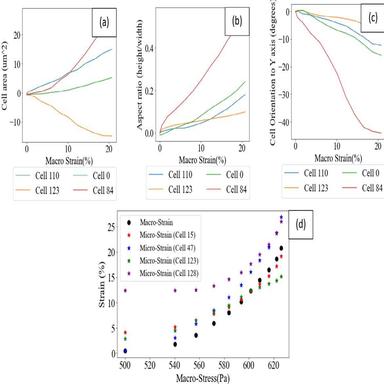
Material analysis step to extract geometrical and material characteristics from the tracking information demonstrated for arbitrarily chosen cells, (a) area of cells, (b) height/width aspect ratio of cells, (c) rotation angle of cells, and (d) equivalent von Mises strain.